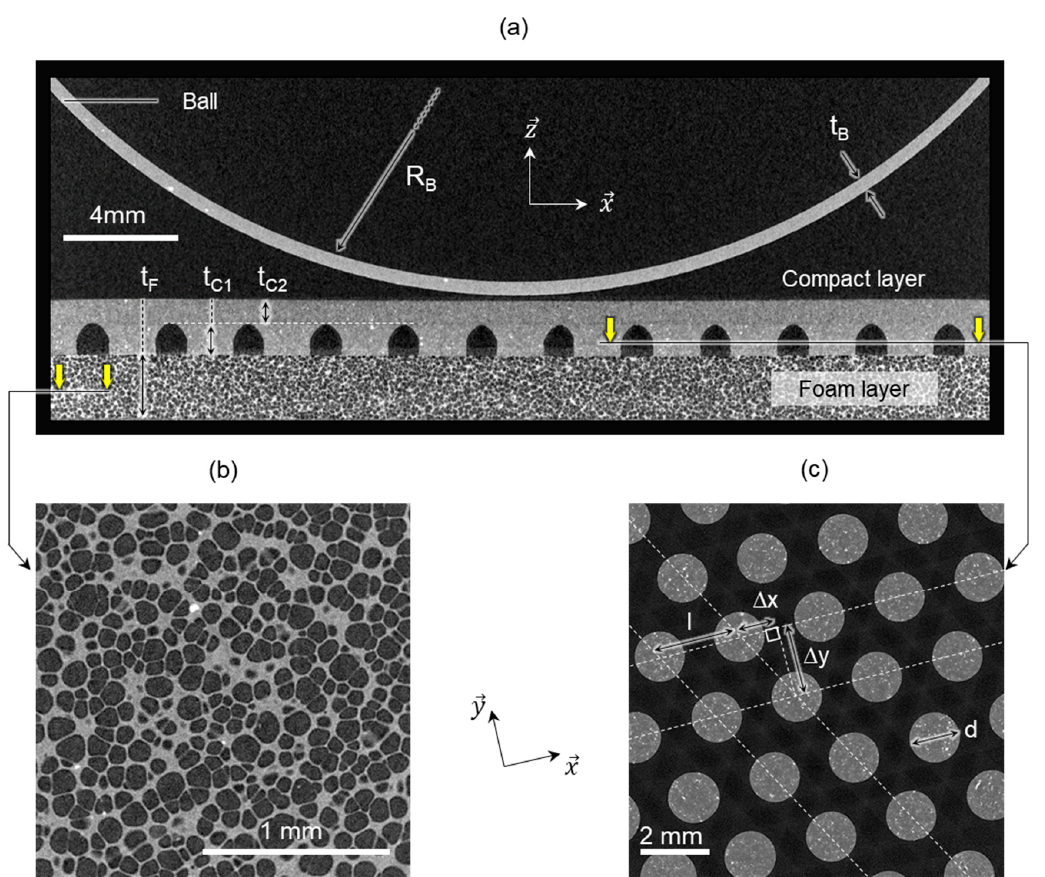
Figure 1. X-ray tomography measurements ( a ) 2D X-ray tomography imaging of the ball and foam + compact pad (Voxel size = 17 µm). ( b ) Section view (xz) of the foam microstructure (Voxel size = 2.5 µm). ( c ) Section view (xy) highlighting the periodic pattern of the circular pimples (Voxel size = 17 µm).